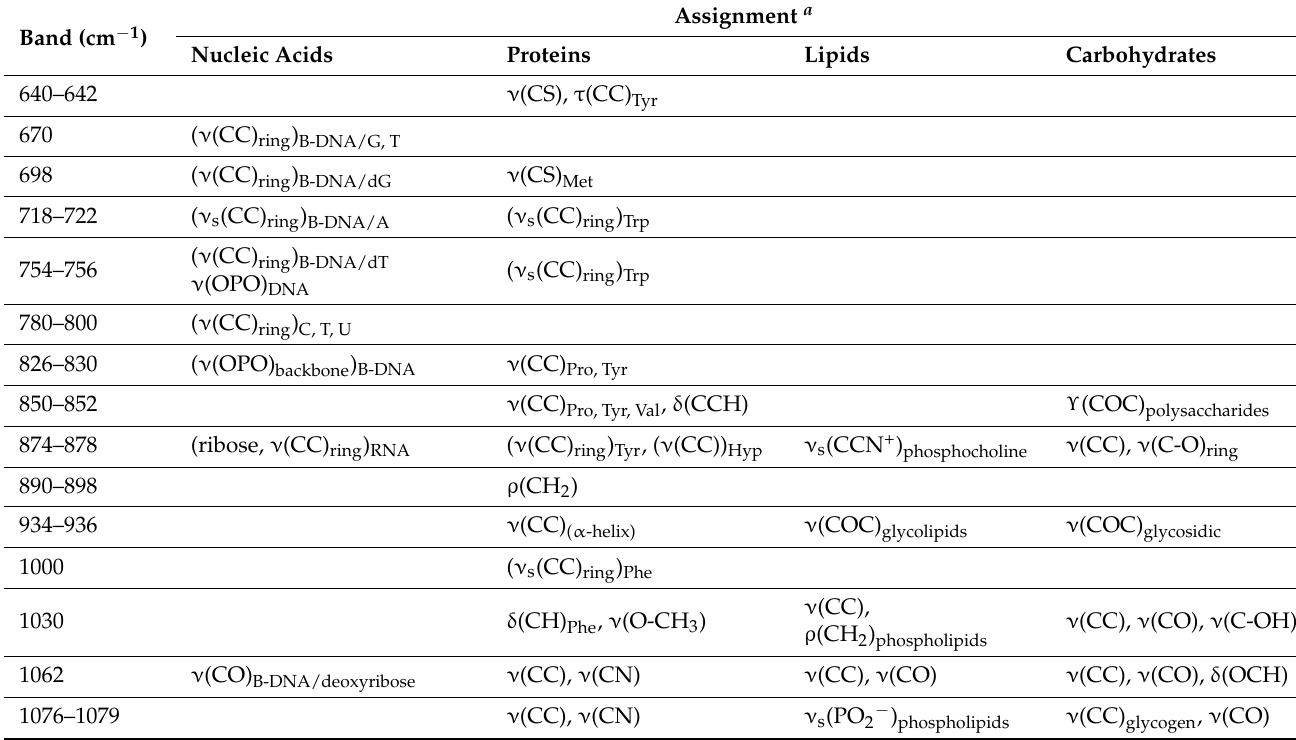
Table 1. Raman and FTIR experimental data for the human breast cancer cell lines MDA-MB-231, MDA-MB-468, HCC-1143 and MCF-7.